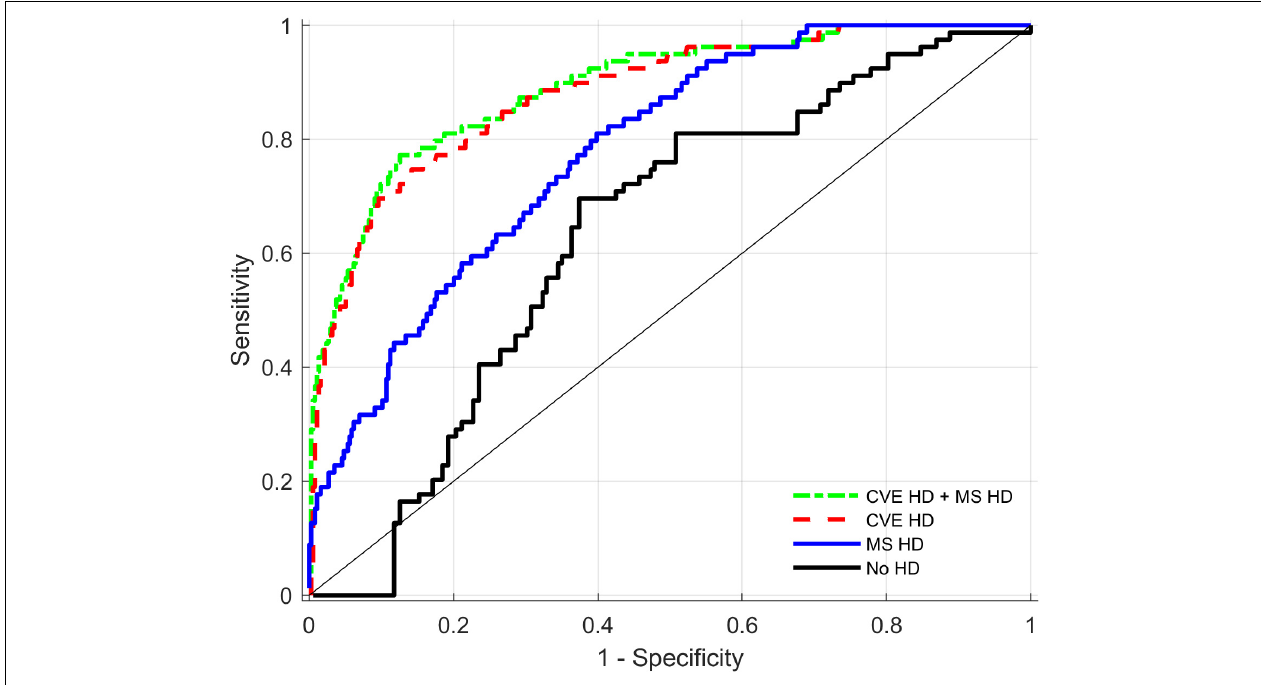
FIGURE 3 | Receiver operating characteristics (ROC) curves for Health distances (HD) of Cardiovascular endurance (CVE), Muscle strength (MS), and the combination of both HDs as predictors of Heart Failure. ROC curves present combined output from all imputed datasets (see section “Materials and Methods”).